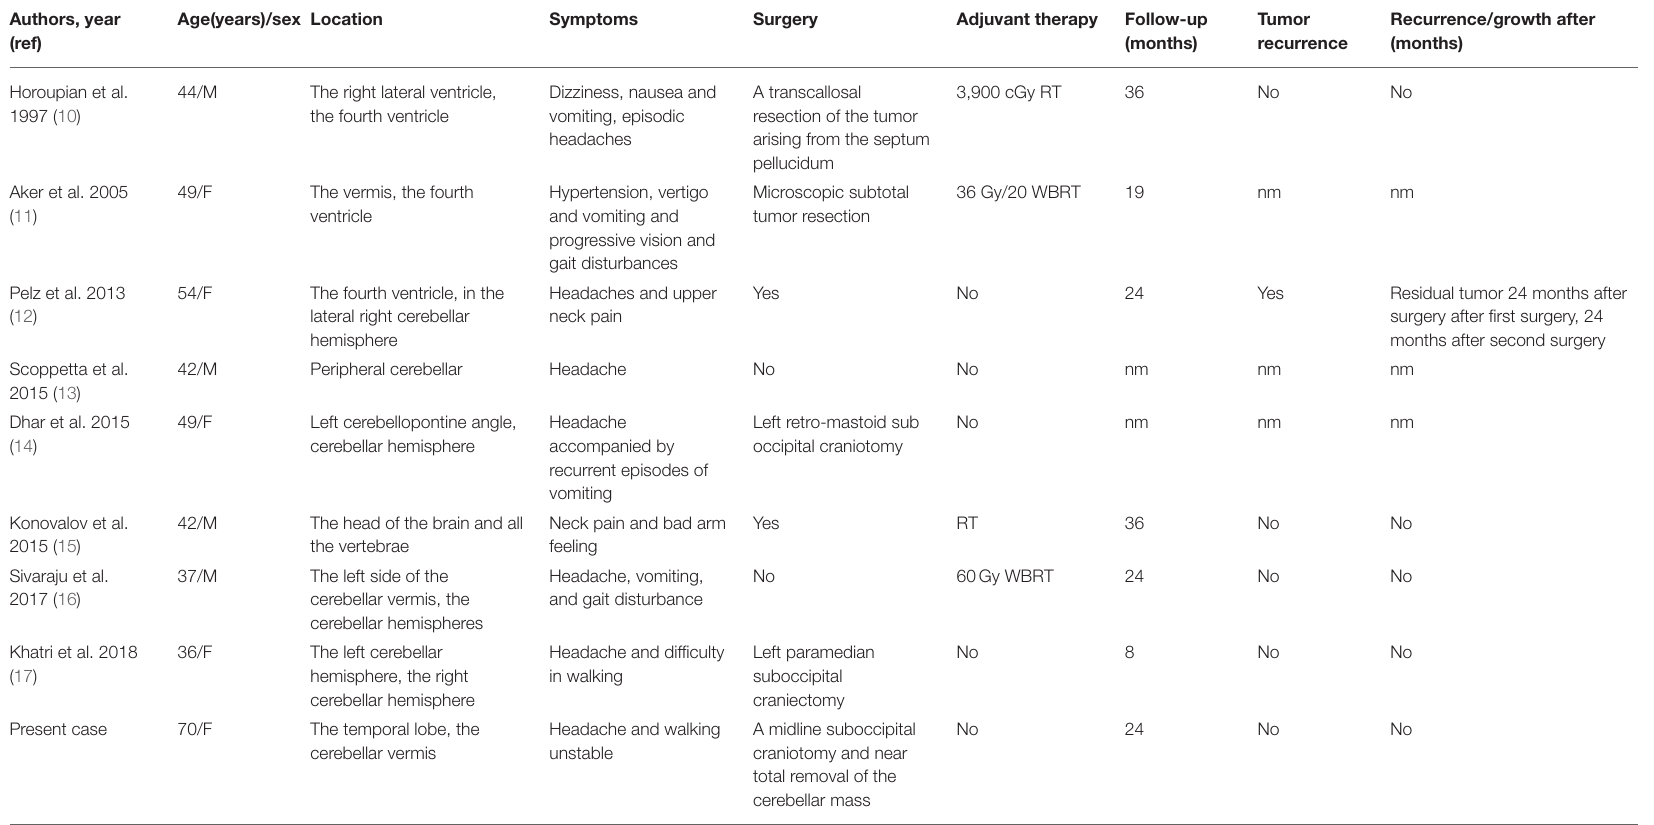
TABLE 1 | Summary of previously reported cases of multiple cerebellar